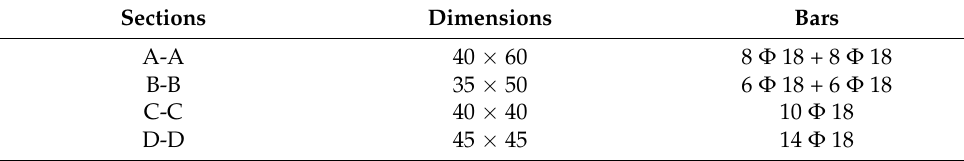
Table 6. Masonry characteristics.